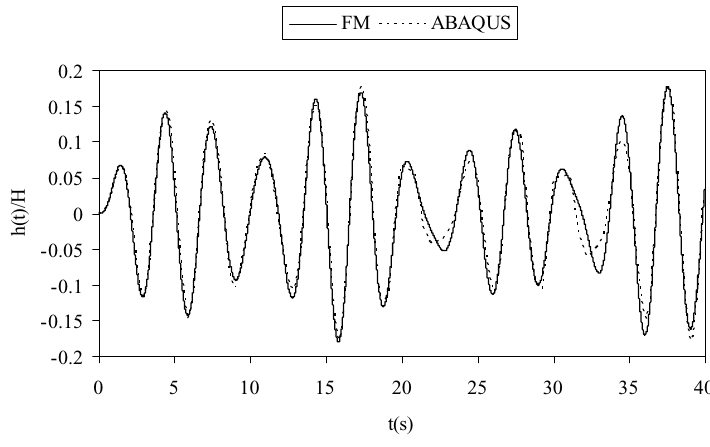
Fig. 5. Nonlinear dynamic response h ( t ) of a single-span cable ( f =0.3H z ,q 0 = 0.03 H / l )